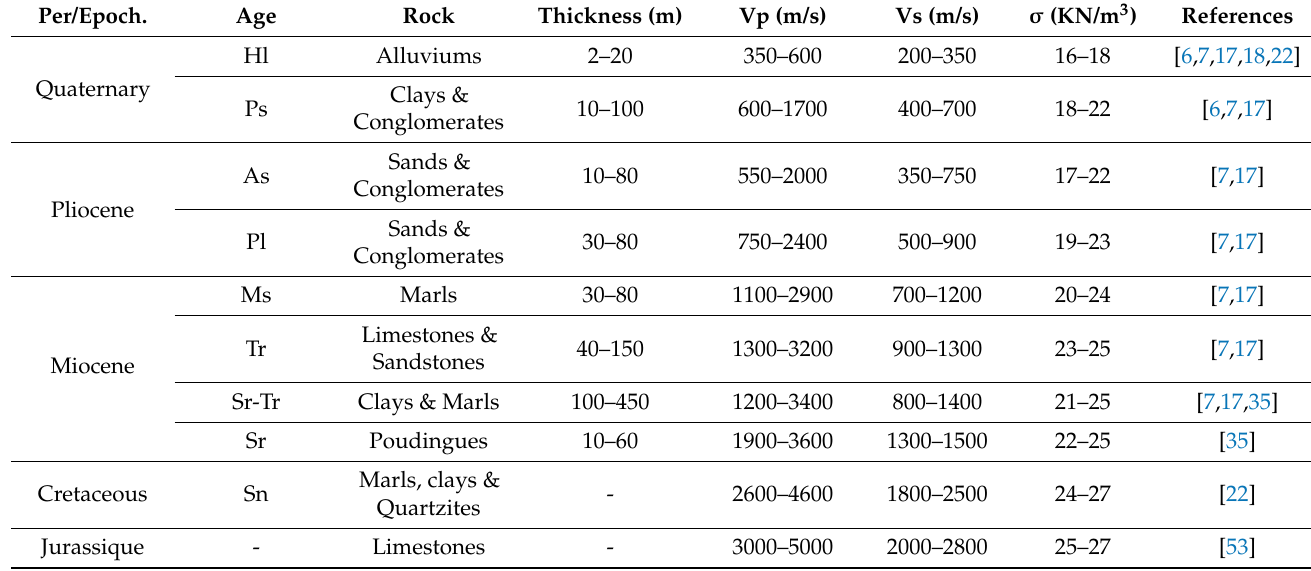
Table 1. Geotechnical information used for the inversion process. Hl: Holocene. Ps: Pleistocene. As: Astian. Pl: Placenzian. Ms: Messinian. Tr: Tortonian. Sr: Seravallian. Sn: Senonian.